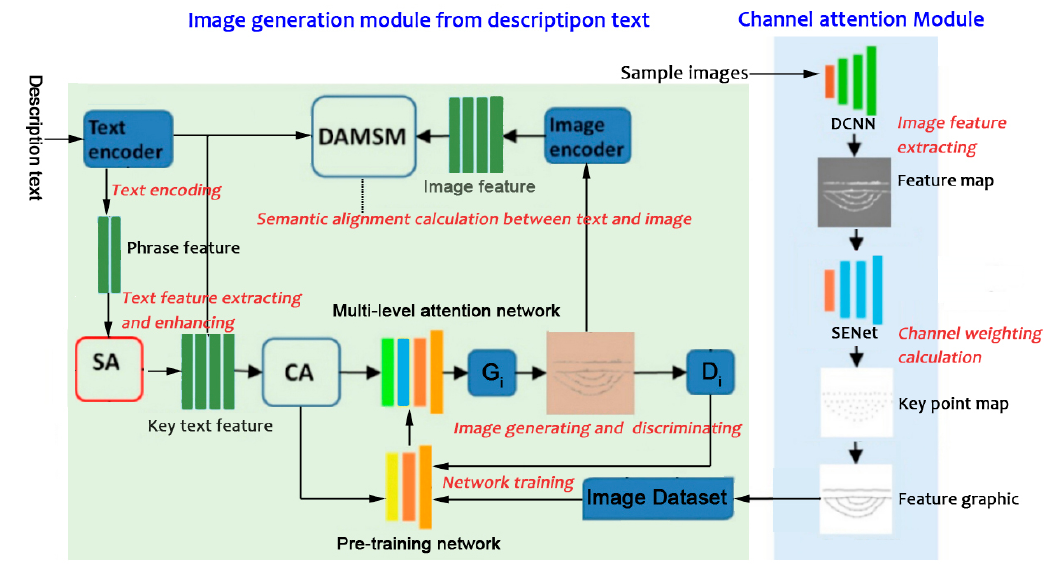
Figure 5. Image generation method from description text.